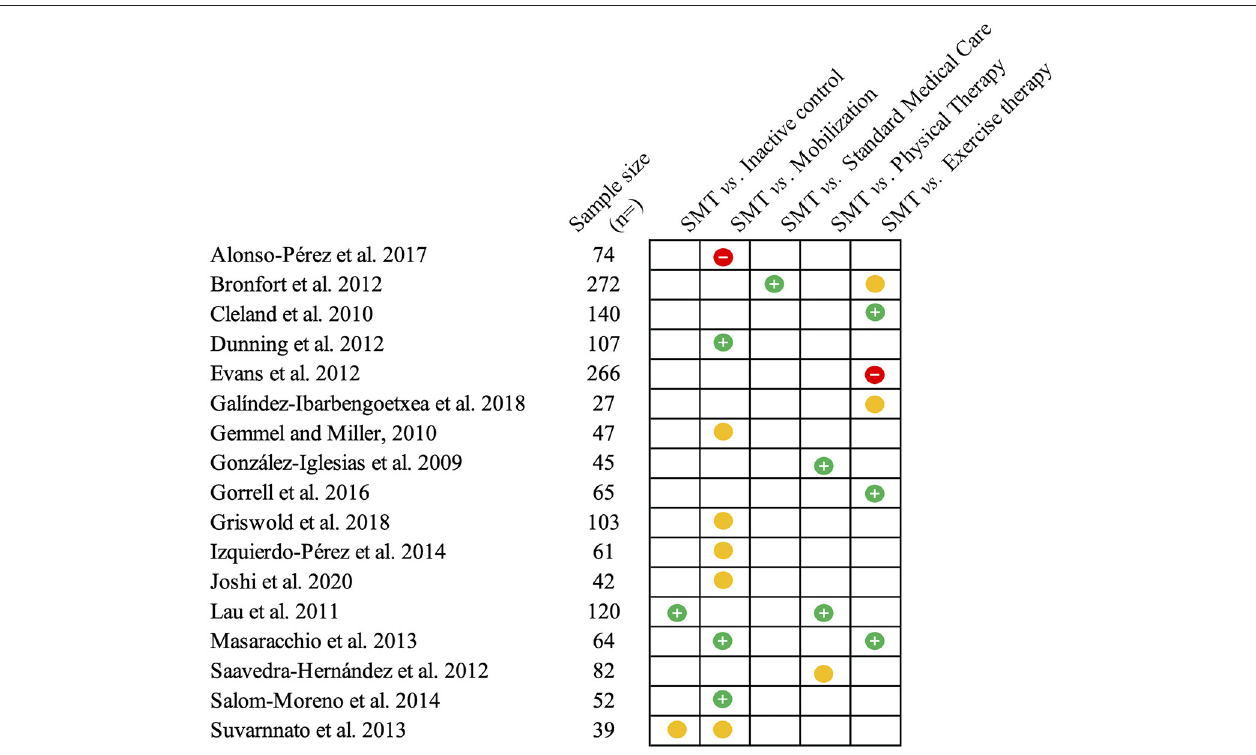
FIGURE 1 | Summary of the studies reviewed on neck pain. This figure summarizes the main findings from the studies presented on the efficacy (compared to inactive controls) and effectiveness of spinal manipulative therapy (SMT) against different comparators for acute and chronic neck pain. The green circles with the positive sign indicate studies reporting pain-related outcomes in favor of SMT against or when added to the comparator. Yellow circles indicate similar effectiveness. Red circles with a negative sign indicate that SMT is inferior or does not add any value to the